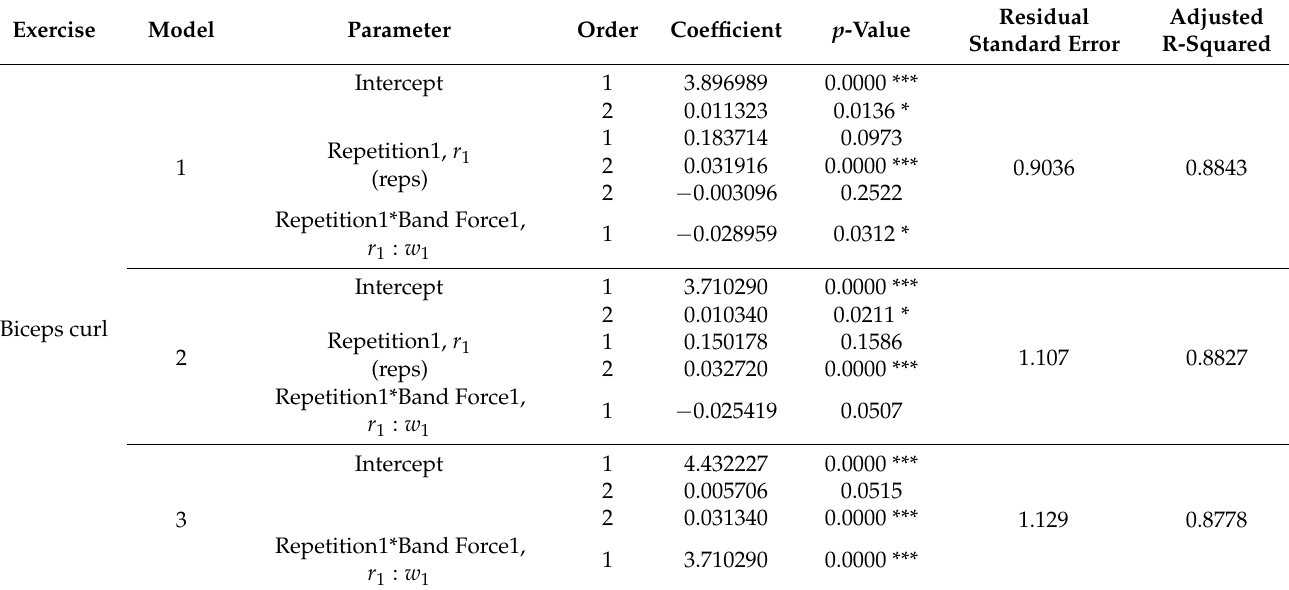
Table A4. Biceps curl 1 − RM equations and model